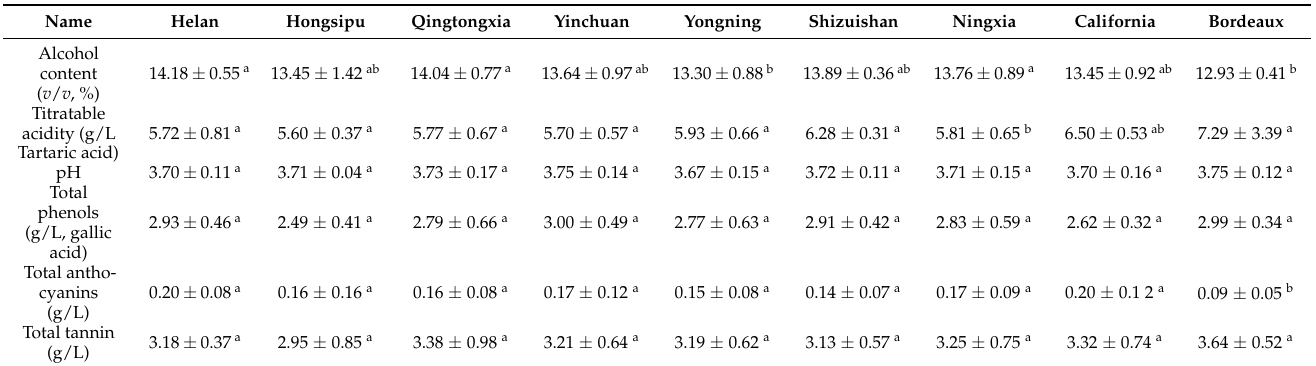
Table 1. Oenological parameters from the six sub-regions of Ningxia, California, and Bordeaux. ( p <